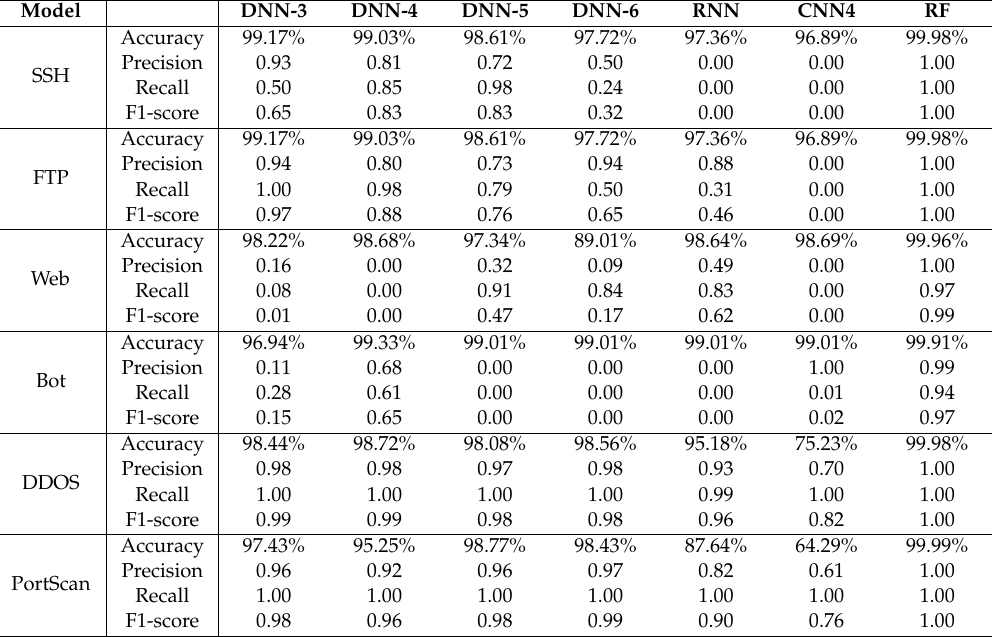
Table 7. Comparison of the e ff ects of di ff erent models based on CICIDS 2017